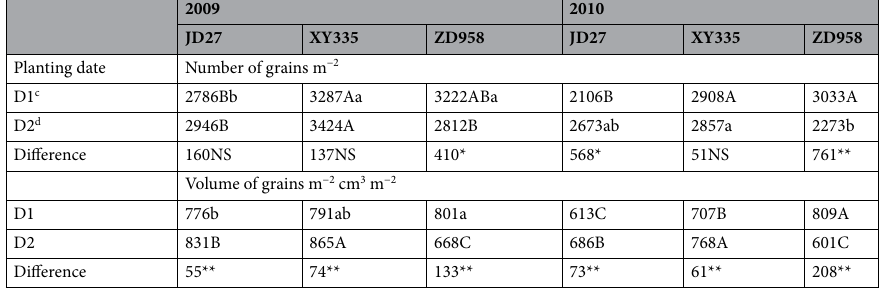
Table 6. Effects of planting date and hybrid maturity on number of grains m −2 , and volume of grains m −2 of dryland corn at Lishu city, Northeast China during 2009 and 2010 growing seasons. a Means within a row followed by a different lower-case letter differ at P < 0.05. Means within a row followed by a different upper- case letter differ at P < 0.01. b NS, not significant. c D1 represents the planting date of maize in early May. The planting dates for 2009 and 2010 were May 2 and May 4, respectively. d D2 represents the planting date of maize in mid-May. The planting dates for 2009 and 2010 were May 12 and May 14, respectively. * Significant at the 0.05 level. ** Significant at the 0.01